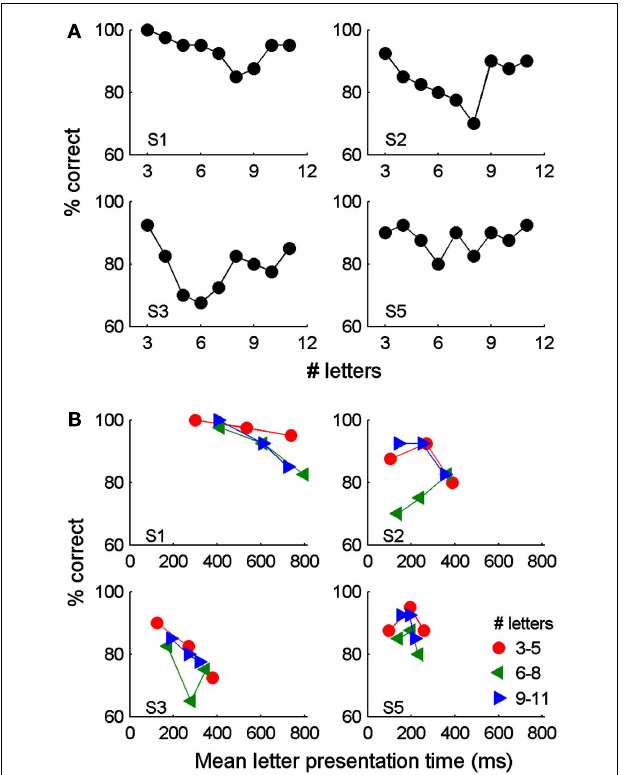
FIGURE 2 | Reading of isolated words using the ESP-Letters method in which participants determined the rate of letter presentation within each word. Reading accuracy as a function of word length (A) and mean letter presentation time (B) are shown separately for four participants, who each viewed a total of 360 words. In (B) , each data point represents the mean performance on trials from each tercile of letter presentation times. As longer words take longer to present, words were also grouped by